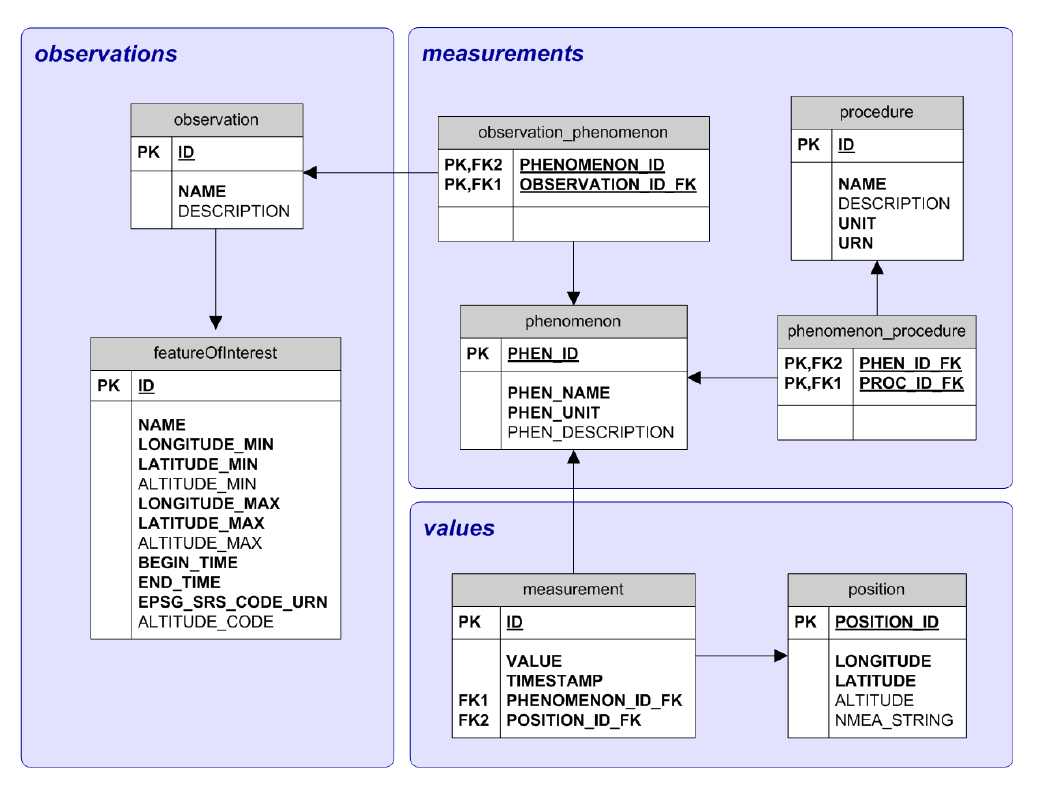
Figure 8. Relational Schema of the Embedded Measurement Database